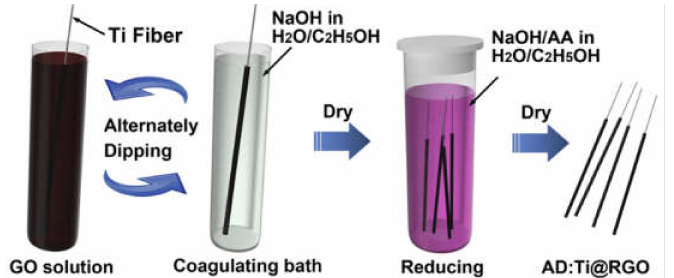
Figure 14. Schematic representation of the synthesis of AD:Ti@RGO via the drying and dipping method for applications in supercapacitors. Reproduced with permission from [210]. IScience,